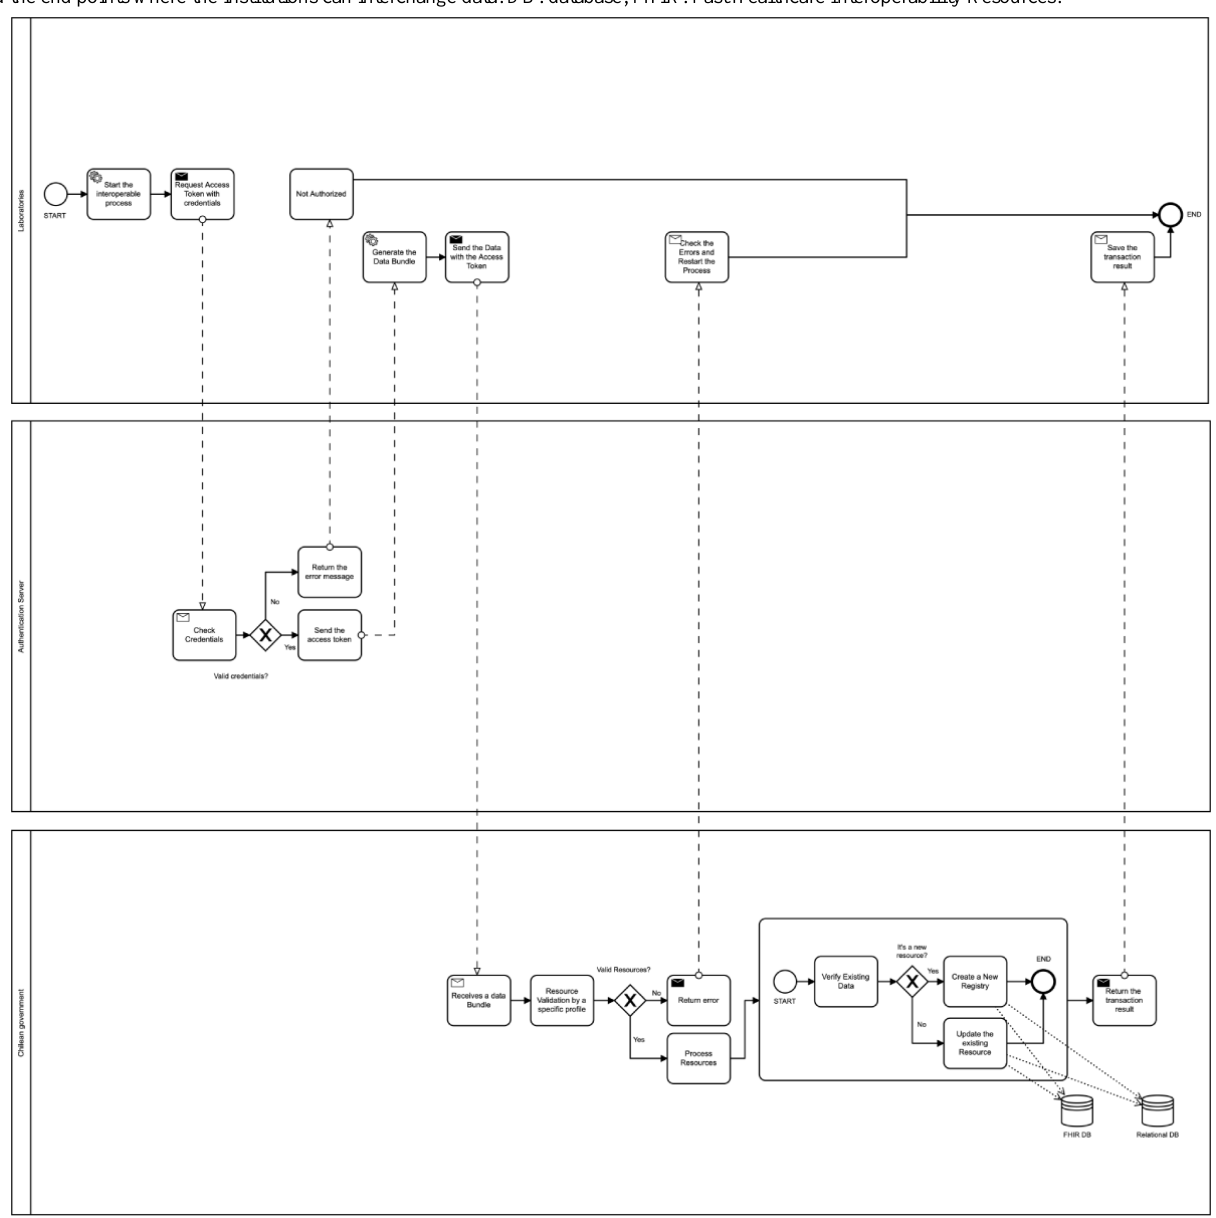
Figure 4. Business Process Model and Notation diagram for the interoperable platform. The process modeled defines the workflow of the